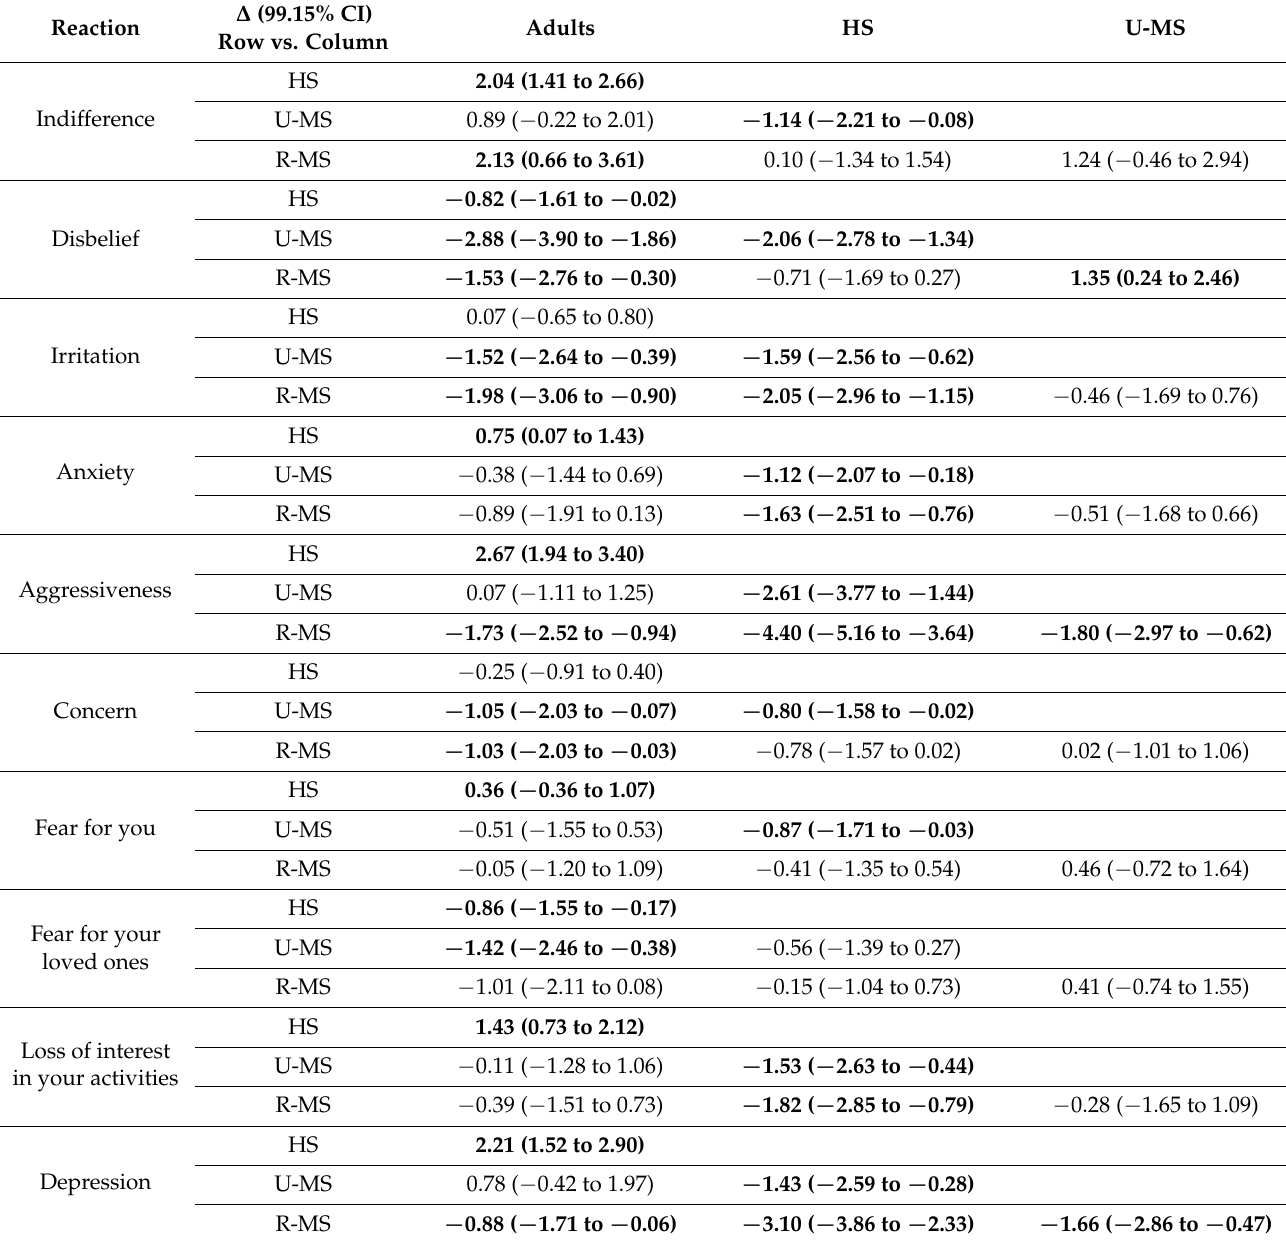
Table 3. Multiple comparisons for the 10 items investigated by the questionnaire (data in bold indicate the most significant difference between adults and students in terms of their emotional